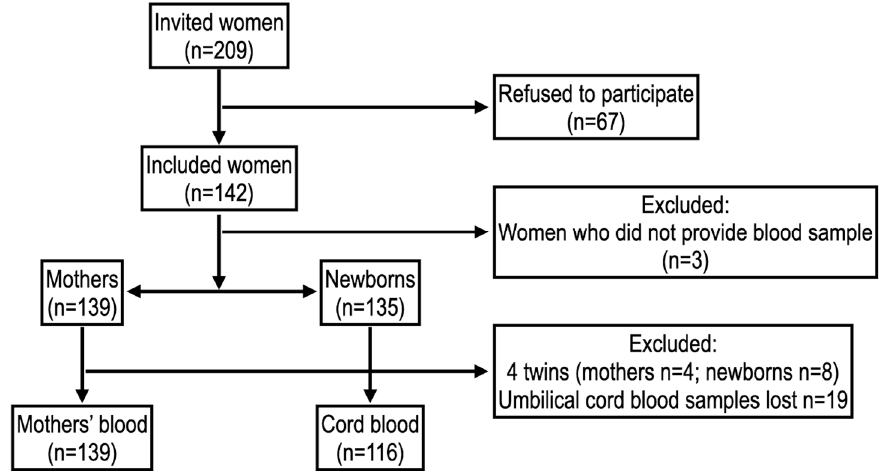
Figure 1. Flow diagram of the study population.